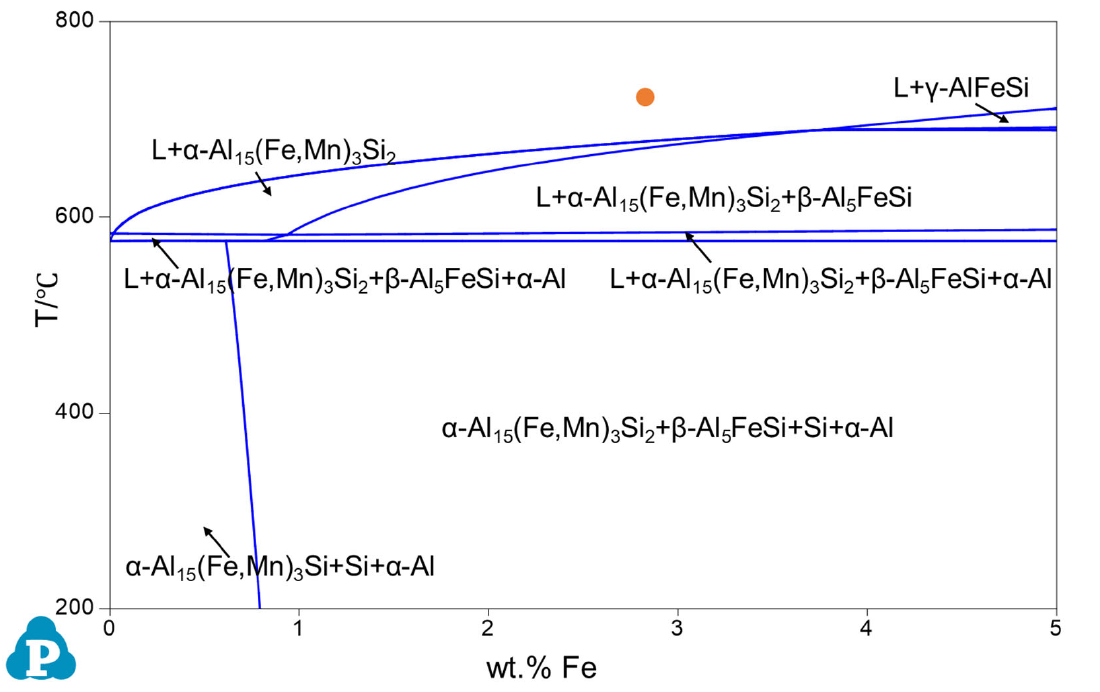
Figure 6. The calculated phase diagram of Al-11.7Si-0.6Mn-xFe under Scheil model condition showing that the α -Al 15 (Fe, Mn) 3 Si 2 is the calculated equilibrium phase for Al-11.7Si-0.6Mn-2.8Fe alloy. Note the orange point shown in the diagram indicates the alloy composition of Al-11.7Si-0.6Mn-2.8Fe alloy.